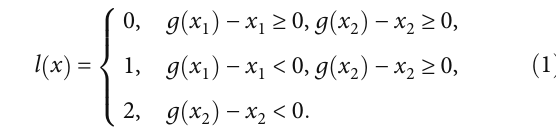
Figure 11: Third generation of f